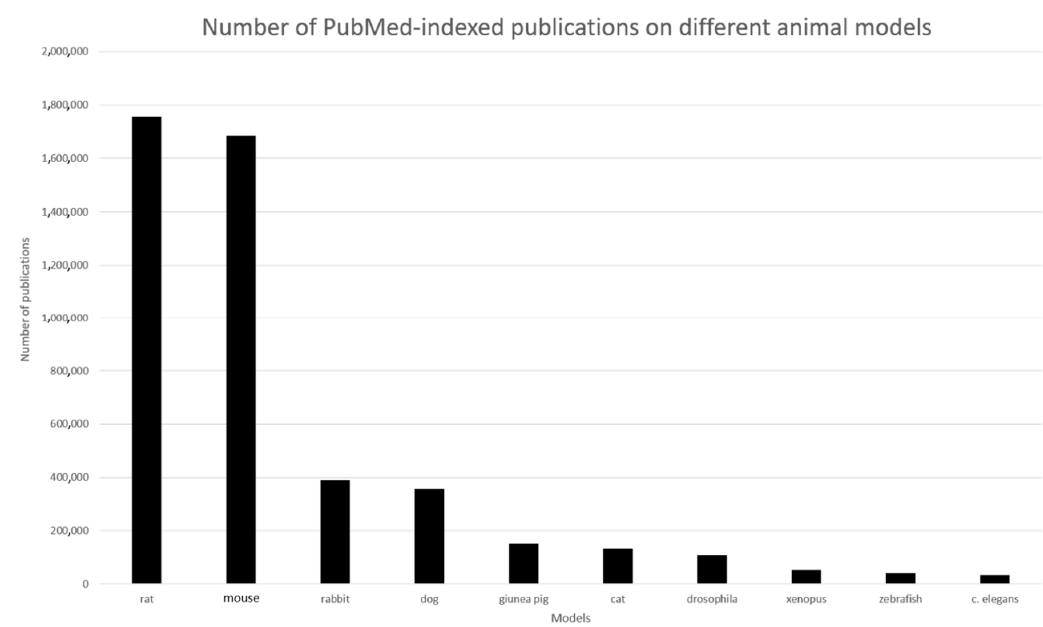
Figure 2. Number of Pubmed indexed publications on different animal models. The number of publications is the number obtained when entering the keyword in the search bar on PubMed website.